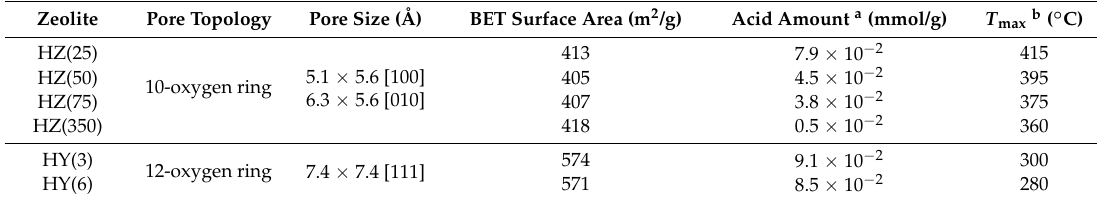
Table 1. Physical and acidic properties of the zeolite catalysts.